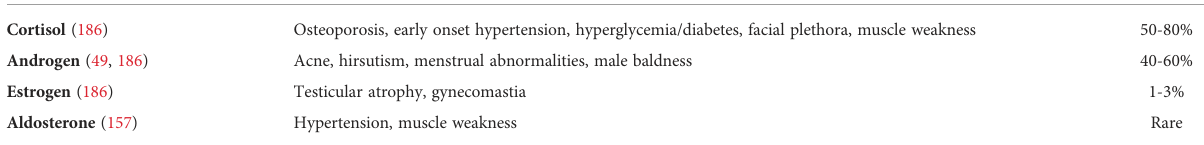
TABLE 1 Hormone secretion of functional adrenocortical